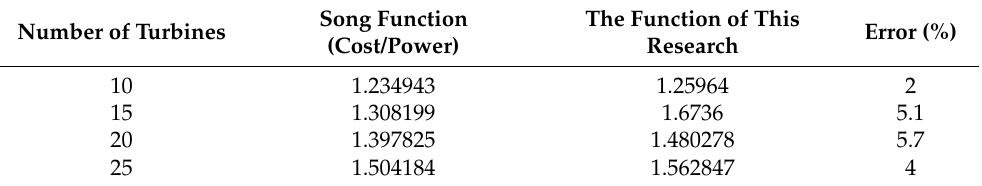
Table 4. The validation of the objective function for cost per power in the second scenario. Song Function The Function of This Number of Turbines (Cost/Power)